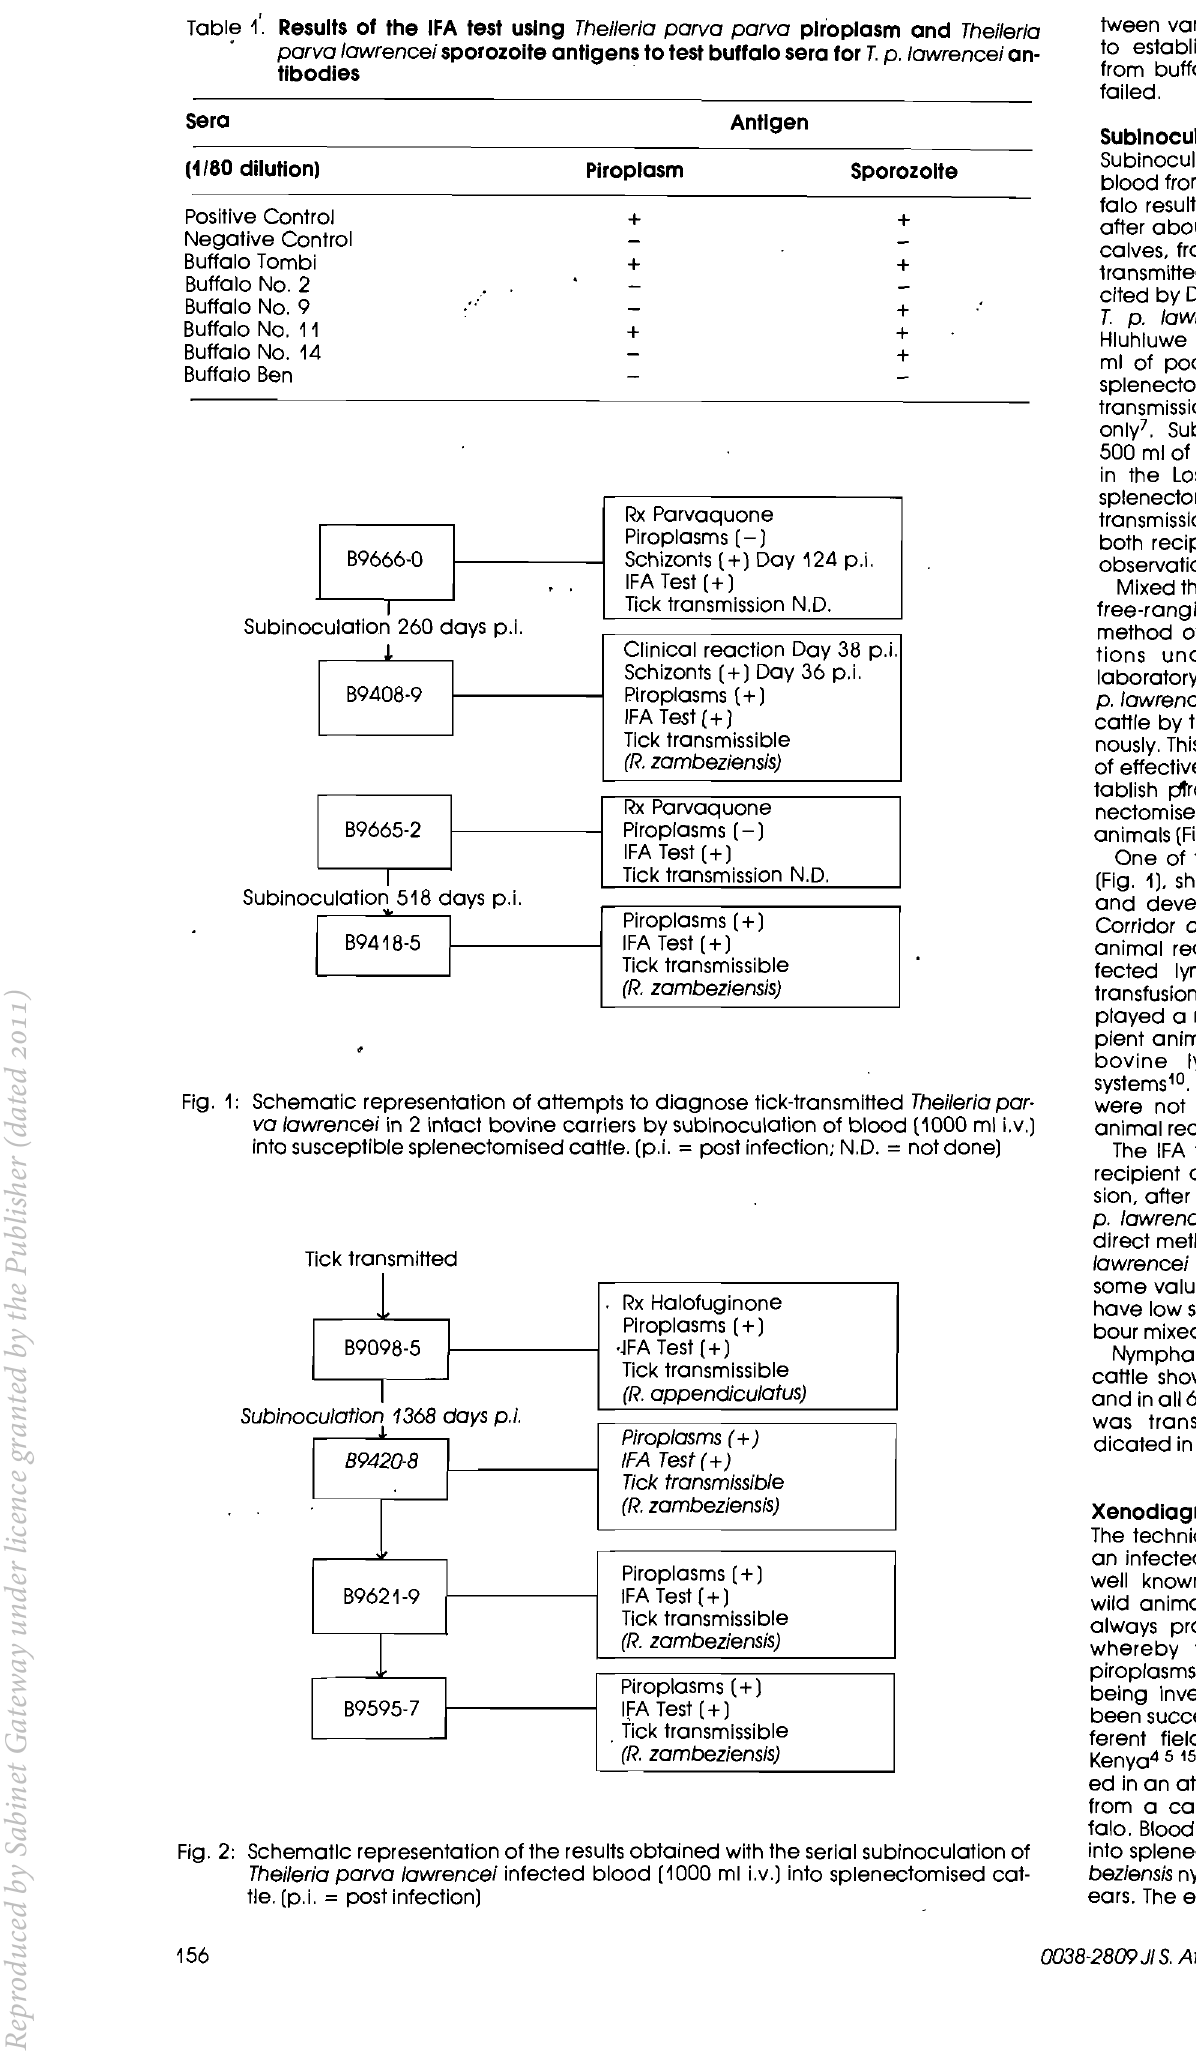
Fig. 2: Schematic representation of the results obtained with the serial subinoculation of Theileria parva lawrencei infected blood (1000 ml i.v.) into splenectomised cat tle. (p.i. = post